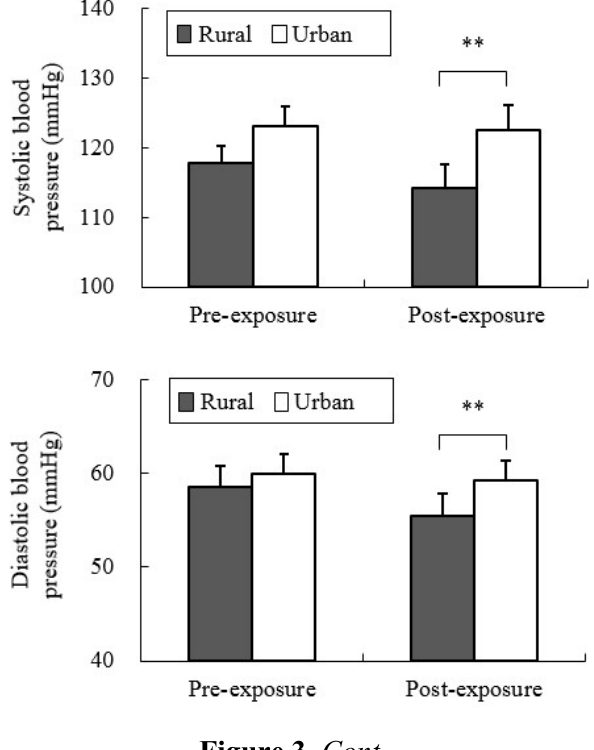
Figure 2. Comparison of salivary cortisol concentrations in participants at pre- and post- exposure sessions between rural and urban environments. Mean ± SE; N = 11; * p < 0.05; paired t